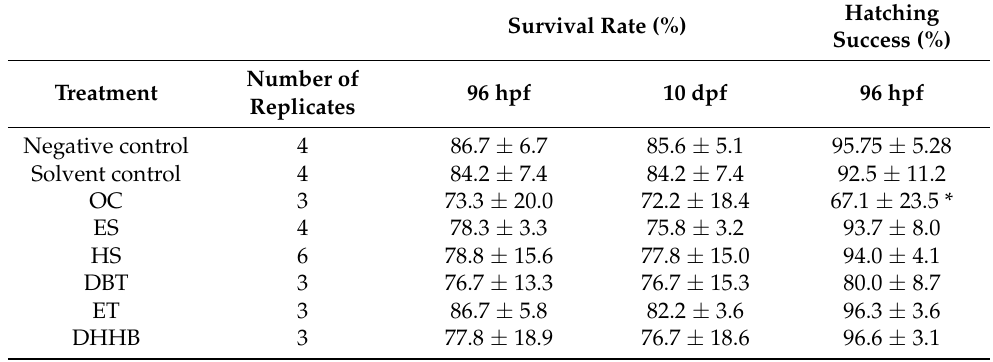
Table 2. Survival and hatching success of zebrafish assessing UV filter toxicity. Mean values ± standard deviation. * indicates a significant difference from the solvent control experiment ( t -test, p <